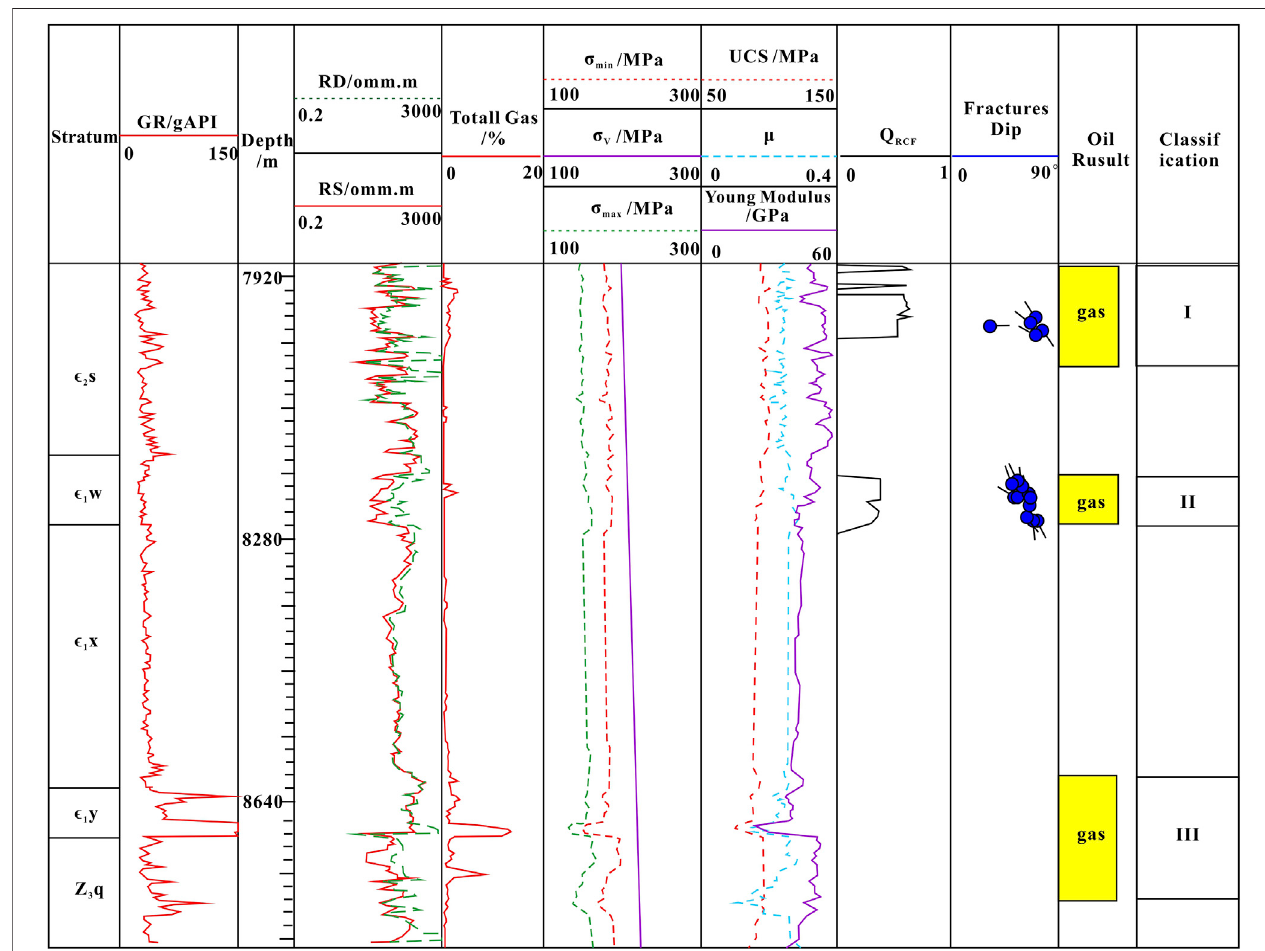
FIGURE 5 | Geomechanical interpretation and reservoir classi fi cation in Well L1. It can be seen that the logging interpretation of the reservoir of the third section (yellow fi lled rectangle) is a gas reservoir, but there are great differences in the geomechanical parameters. The fi rst section is de fi ned as Class I with lower in situ stress, fi ve natural fractures, and higher Q RCF ,the second section isClass IIwithhigher stress,medium Q RCF , and 11natural fractures. The GRray ofthethird section changes violently, and the lithology is mainly mudstone and argillaceous limestone, and the stress is high in general, but there is a lower stress section in the middle, but no natural fracture is picked up, which is de fi ned as Class